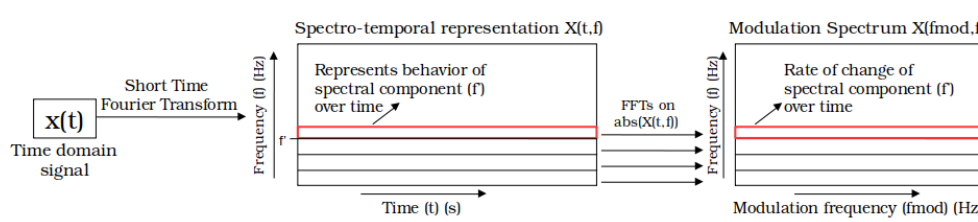
Figure 1. Signal processing steps involved in the computation of a modulation spectrogram. Other methods of computing the representation can be found in